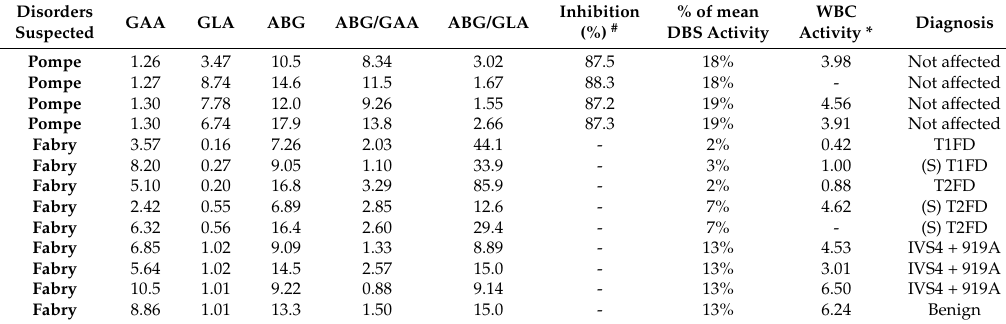
but not the critical criteria would be tested for the inhibition (%). Cases met the critical criteria (ABG/GAA ≥ 20) need the confirmation testings immediately and therefore no values for this inhibition (%). *: Lymphocyte GAA activity with the presence of inhibitor (Normal mean = 25) in newborns suspected of having Pompe disease, leukocyte GLA activity (Normal mean = 60) in